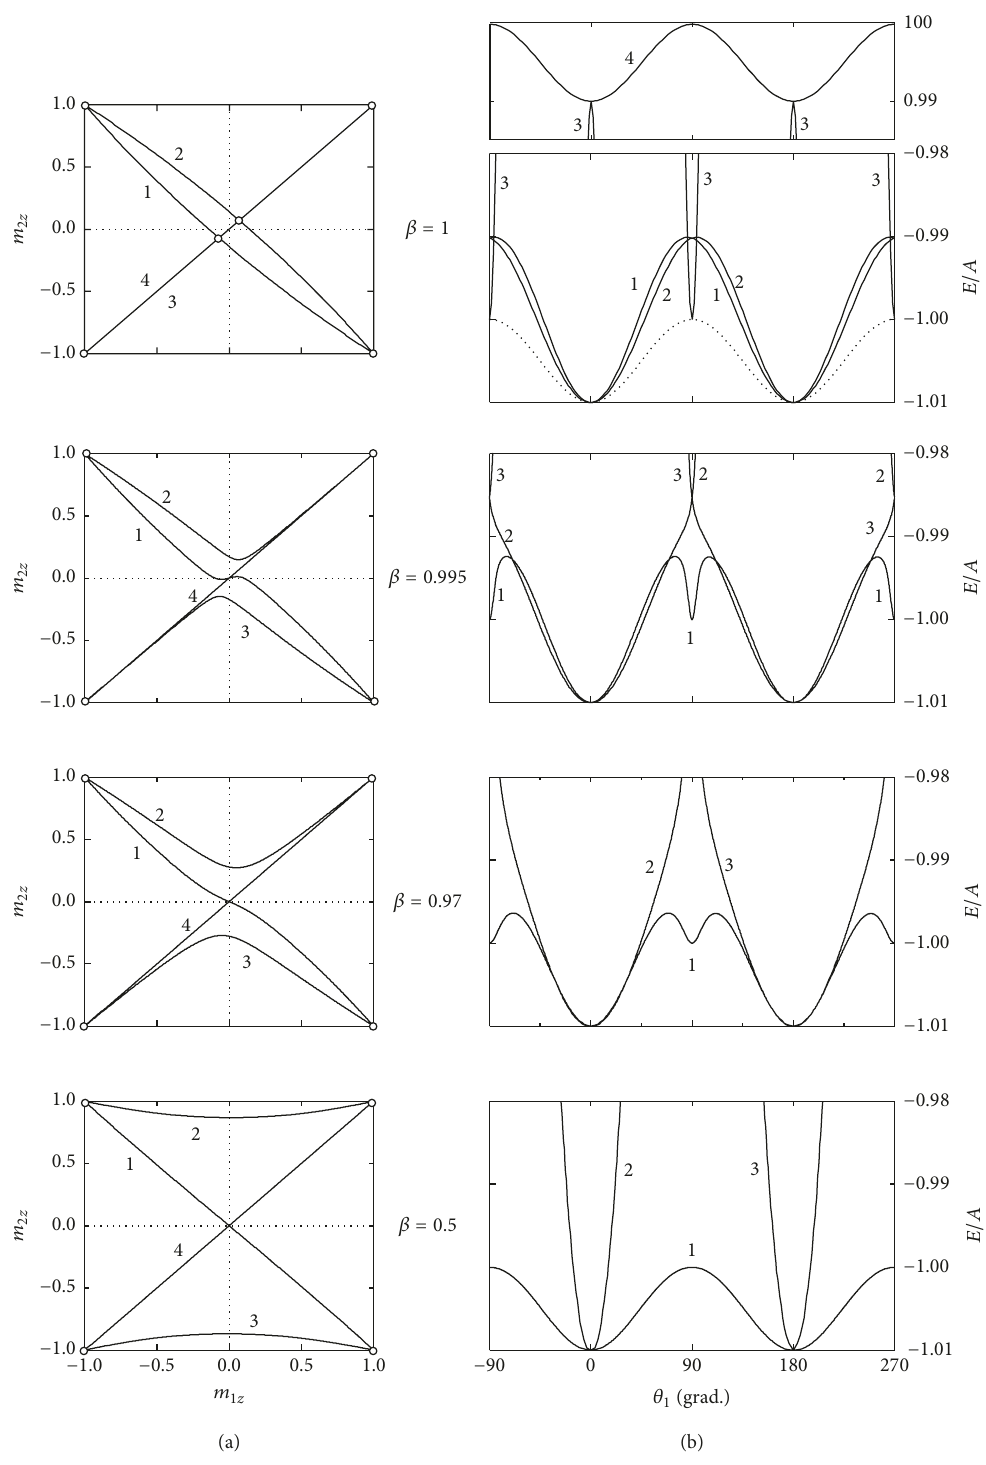
Figure 2: (a) Correlation between projections of the sublattice magnetization vectors 𝑚 1𝑧 and 𝑚 2𝑧 onto the easy axis for four normal precession modes of the vectors M 1 and M 2 of an ideal antiferromagnetic particle ( 𝛽 = 1 ) and “uncompensated” antiferromagnetic particles ( 𝛽 < 1 ) at 𝑘 = 0.01 . Branching points are indicated by the circles. (b) Four excitation branches for 𝛽 = 1 and three low-lying excitation branches 𝛽 < 1 (solid lines) in the energy spectrum of antiferromagnetic particles depending on the angle of deviation of the vector M 1 from the easy axis. The dotted line shows the energy relief for the corresponding ferromagnetic